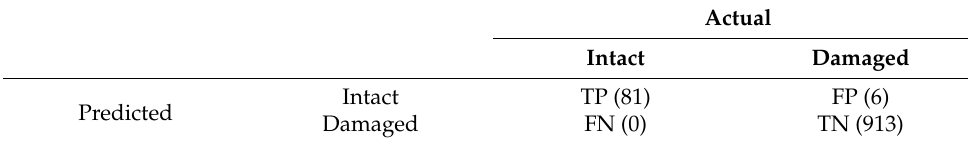
Table 11. Confusion matrix of traffic